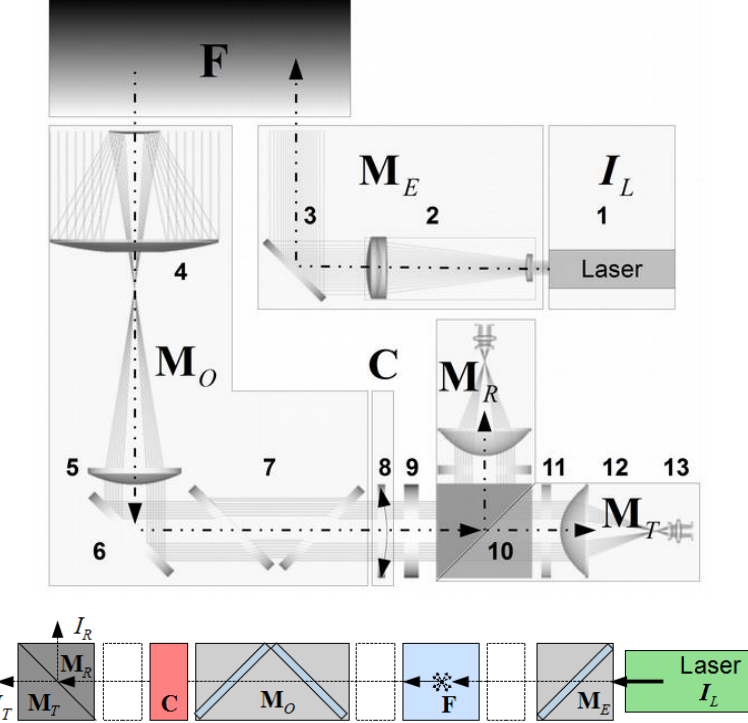
Figure 1 . Top: exemplary depolarisation lidar setup with laser 1, beam expander 2, steering mirror 3, receiving telescope 4, collimator 5, folding mirror 6, dichroic beam splitters 7, a rotating element for polarisation calibration 8, interference filter 9, and polarising beam splitter cube 10 (PBS, polarising beam splitter). The neutral density filters and cleaning polarisers 11, detector optics 12, and the detectors 13. The system can be subdivided in functional blocks which can be described with the Stokes–Müller formalism: I L is the Stokes vector of the laser source, M E is the Müller matrix of the laser emitter optics, F of the atmospheric backscattering volume including depolarisation, M O includes receiver optics as beam splitters, C is the calibrator, and M T,R is the polarising beam splitter including the detector optics for the transmitted ( T ) and reflected ( R ) optical branches. Bottom: simplified schematic of the